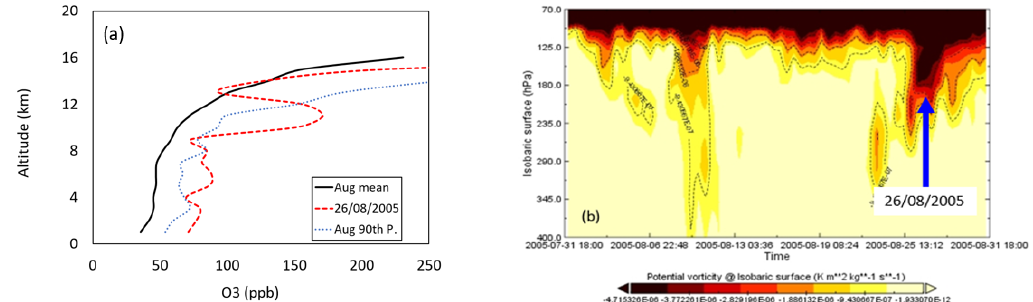
Isobaric surface over Irene on July 2004 (from MERRA-2). Solid line in Figure 5a indicates monthly O 3 average composite, broken line indicates O 3 event and dotted line indicate 90 th percentile composite. Colours in Figure 5b indicates the level of potential vorticity, black indicates high potential vorticity of more than 3 Km −2 kg −1 s −1 while yellow indicates potential vorticity of less than 2 Km −2 kg −1 s −1 . Blue arrow in Figure 5b indicates the event that is associated with O 3 profile in Figure 5a.